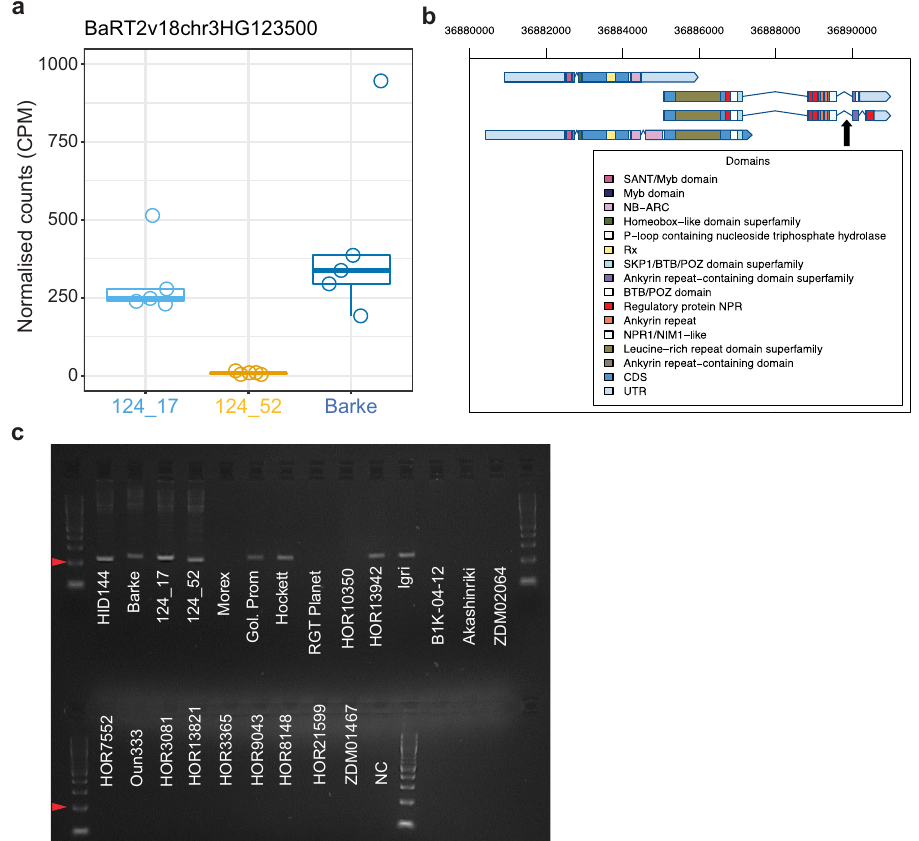
Fig. 7 The NLR gene associated with genotype-dependent transcriptional and genomic variations. a Boxplot showing the root RNA-seq NLR expression across the elite and the sibling lines in normalised counts per million. Individual dots depict individual biological replicates. Upper and lower edges of the box plots represent the upper and lower quartiles, respectively. The bold line within the box denotes the median. Whiskers denote values within 1.5 interquartile ranges. b Schematic representation of the NLR gene transcripts inferred from the RNA-seq data depicting predicted protein domains from InterProScan. The black arrow depicts the predicted amplicon site of the PCR marker. c PCR amplicons partially covering the intron between the LRR and the ankyrin domains in the indicated genotypes-Negative control (NC). A DNA ladder was loaded in the fi rst and last well of each lane, arrowheads indicate the 200 bp fragment. The diagnostic screening was repeated twice with identical results. Source data are provided as a Source data fi